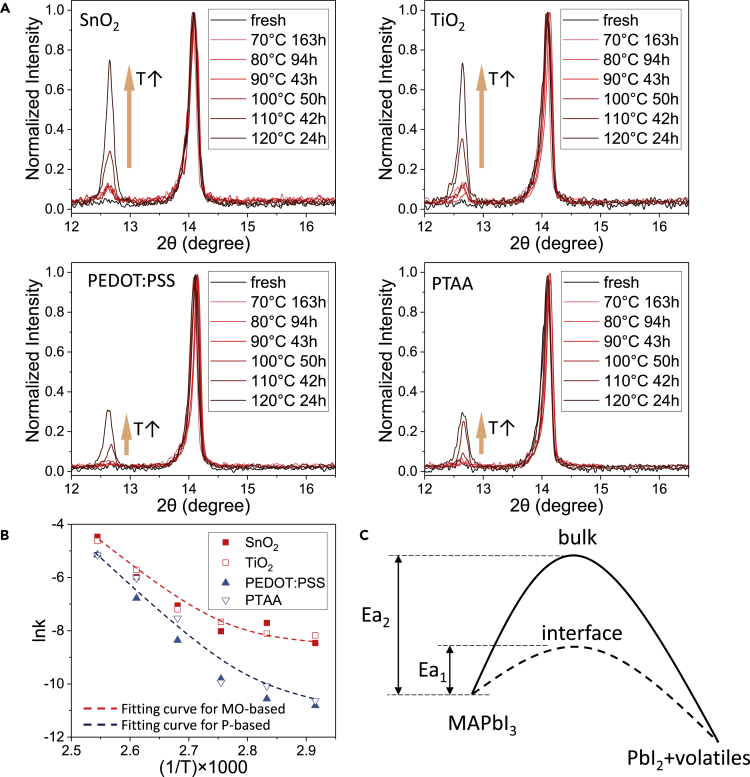
Chemical Deposition Analysis(A) XRD patterns of perovskite films prepared on different substrates after thermal aging on various conditions.(B) lnk-(1/T) plots of perovskite films on different interfacial layers.(C) Diagram of decomposition process taking place in bulk (solid line) and in interface (dash line).Also see Figures S1–S3.